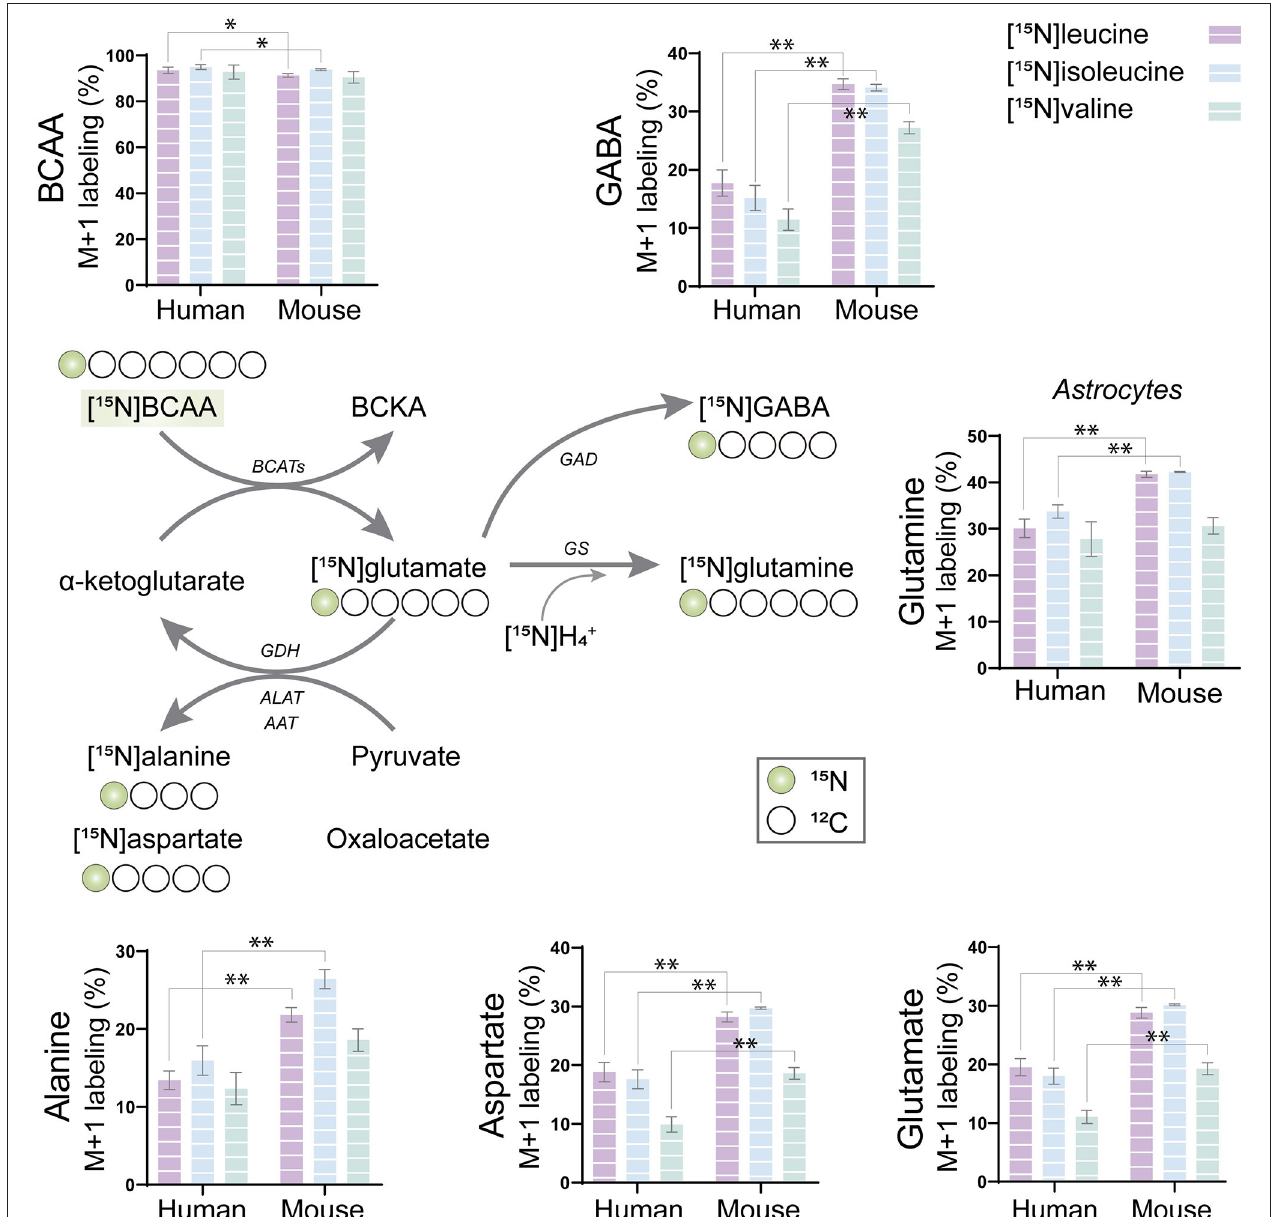
FIGURE 2 | BCAA nitrogen metabolism of human and mouse brain slices. After incubation with [ 15 N]BCAA (valine, leucine, or isoleucine), M + 1 labeling was observed in glutamate, glutamine, gamma-aminobutyric acid (GABA), alanine, and aspartate, indicating significant nitrogen incorporation into amino acids supported by